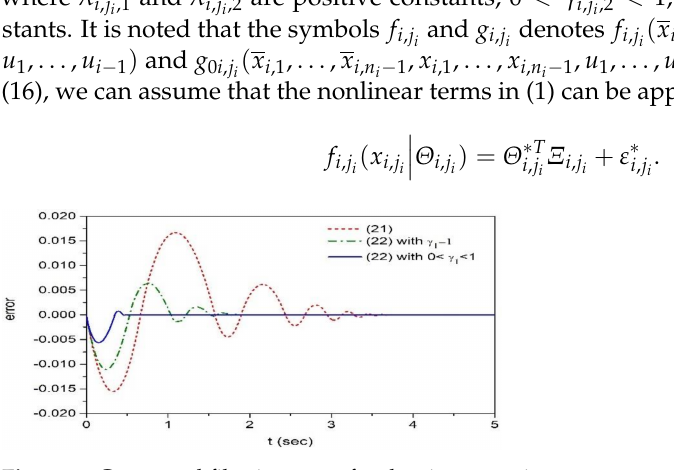
Figure 2. Command filtering error for the sine wave